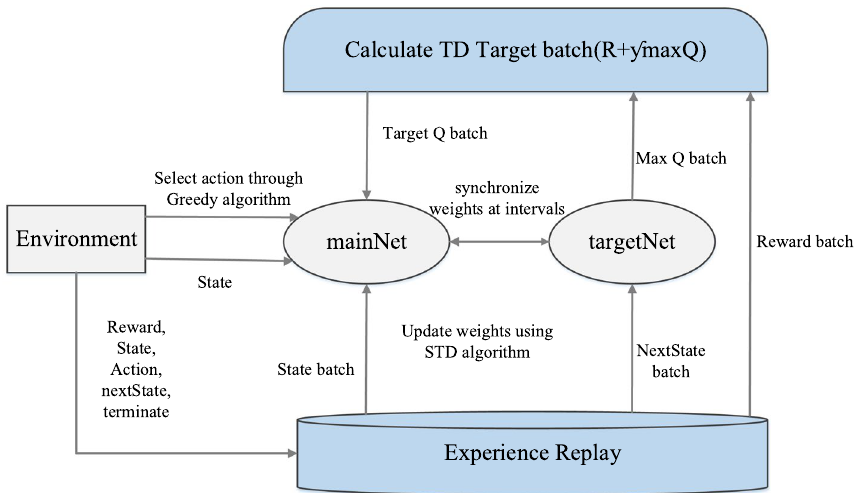
Fig. 5 Algorithm flowchart of